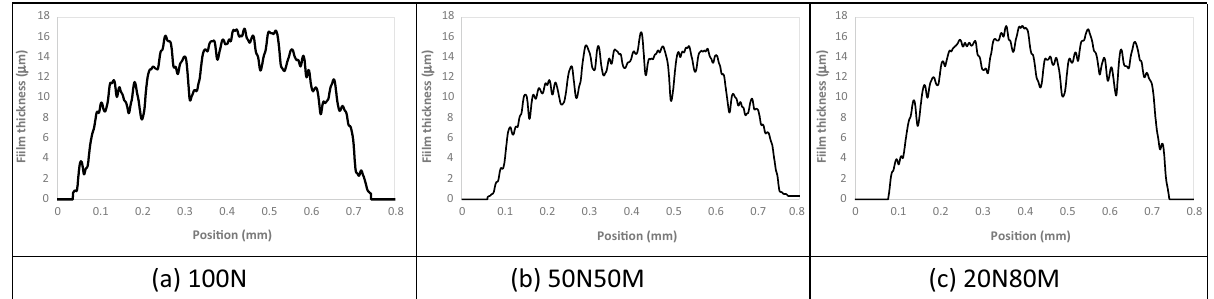
Figure 3. Cross sectional topologies of the 600 mm printed